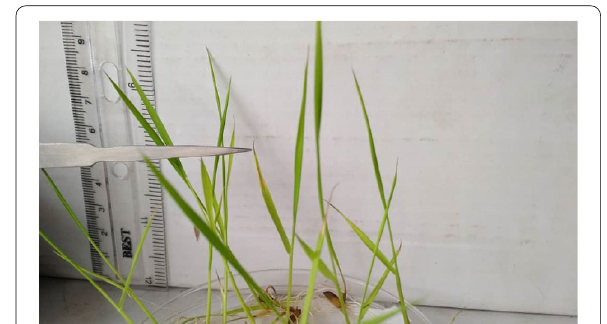
Fig. 8 Alpha amylase at week 2 and 4. Results with similar alphabets on same bars (or line graph) did not differ from each other ( p